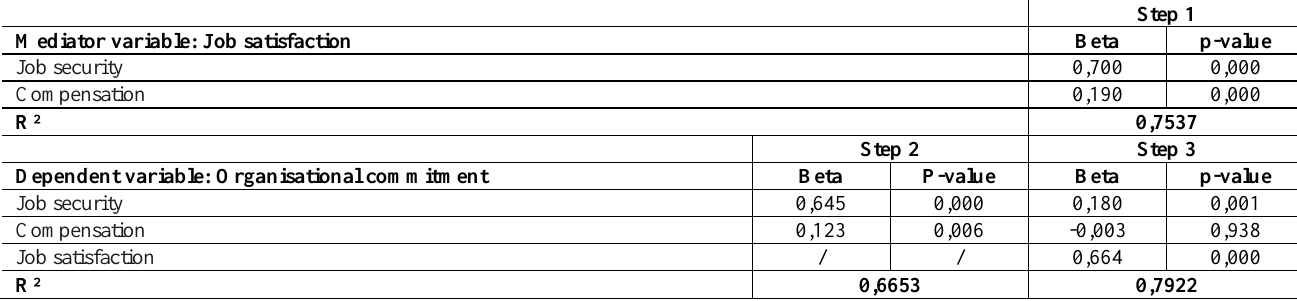
Table 7: Regression analyses testing for